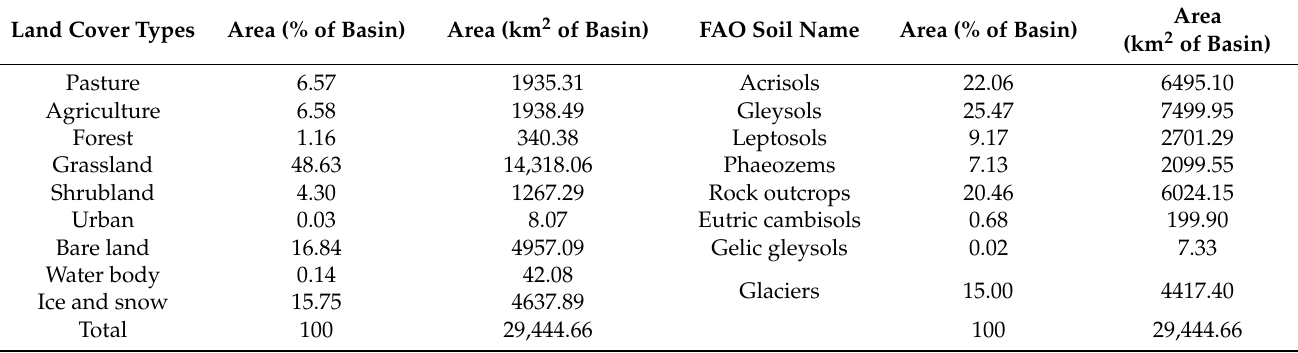
Table 1. Soil and land-use data of the Upper Vakhsh River Basin, based on area and percentage. Land Cover